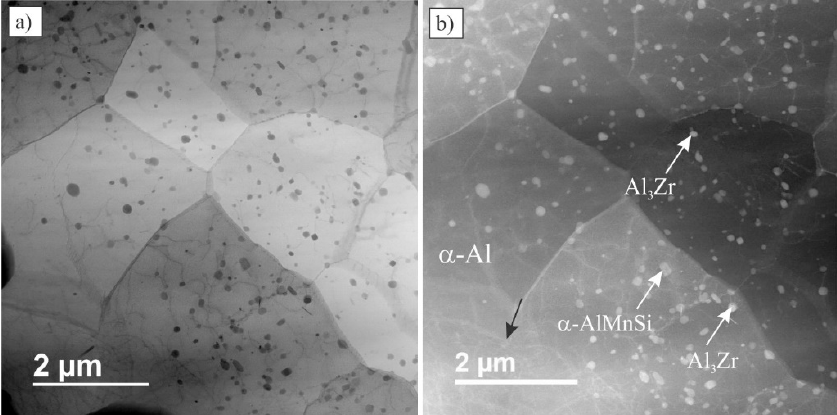
Figure 9. The transmission electron micrographs of the alloy after T6 temper, shoving subgrains and the distribution of dispersoids. ( a ) Bright-field micrograph and ( b ) HAADF micrograph.